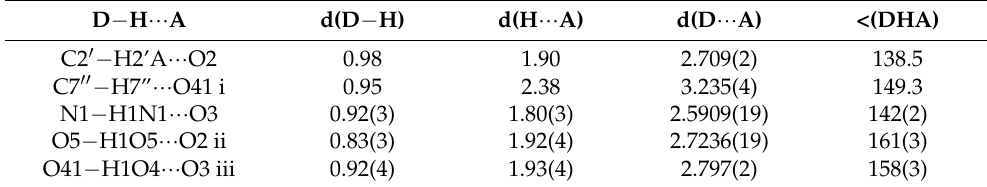
Table 2. Hydrogen bonds for L2 [Å and °].